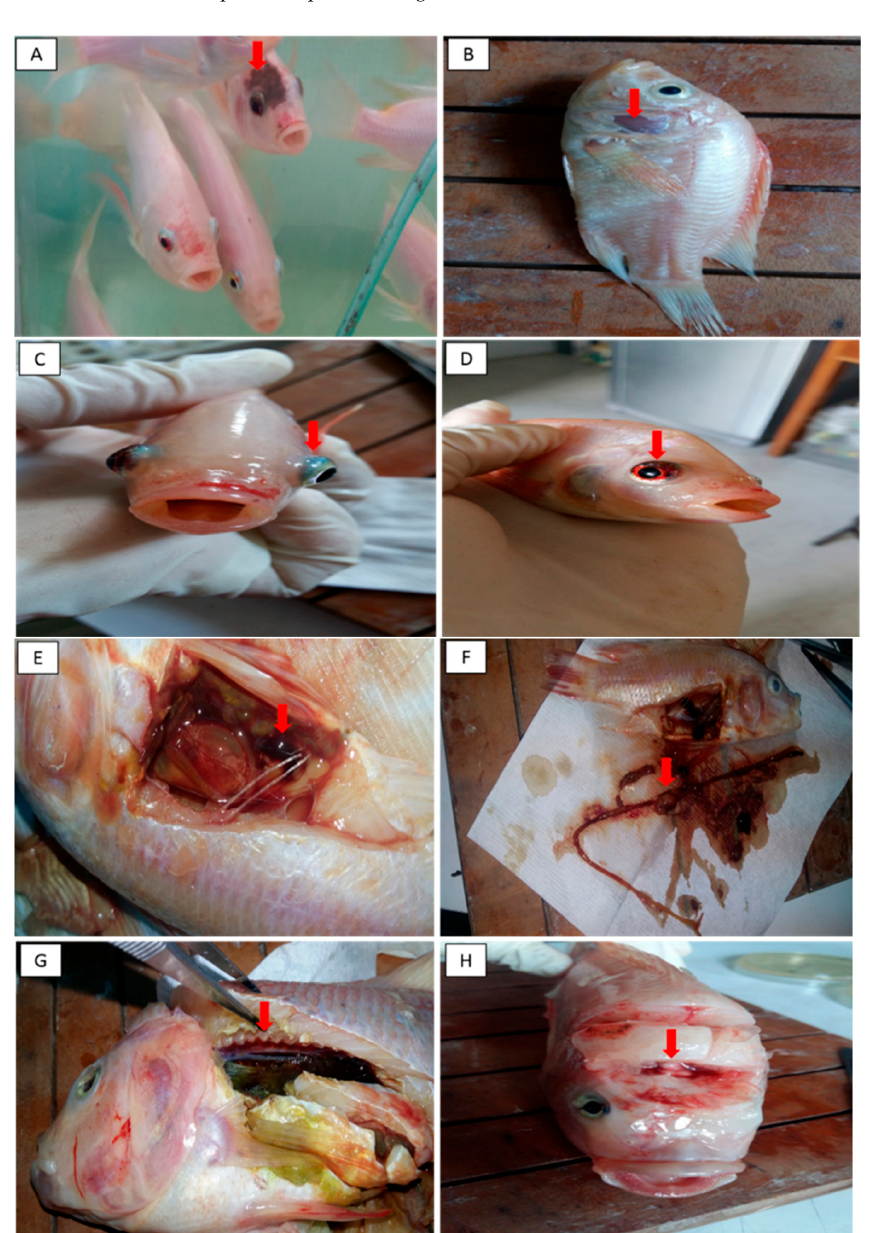
Figure 4. ( A ) skin discoloration, ( B ) haemorrhagic skin, ( C ) exophthalmia (pop-eye), ( D ) haemorrhagic eye ( E ) splenomegaly with multiple granulomas ( F ) empty stomach ( G ) nephritis ( H ) intracerebral haemorrhage.